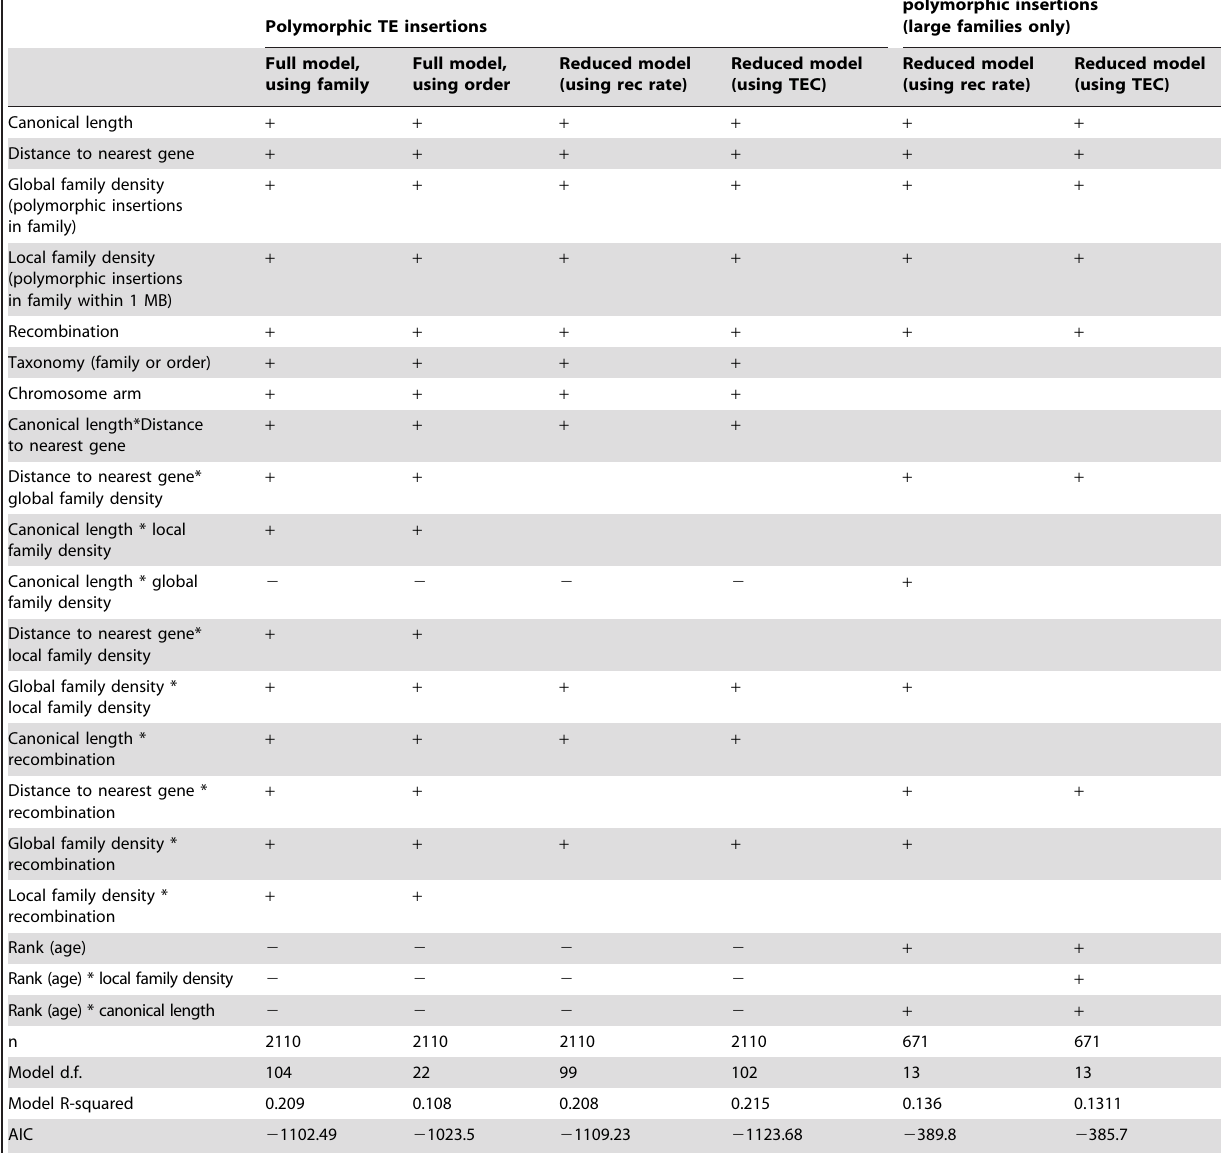
polymorphic insertions (large families